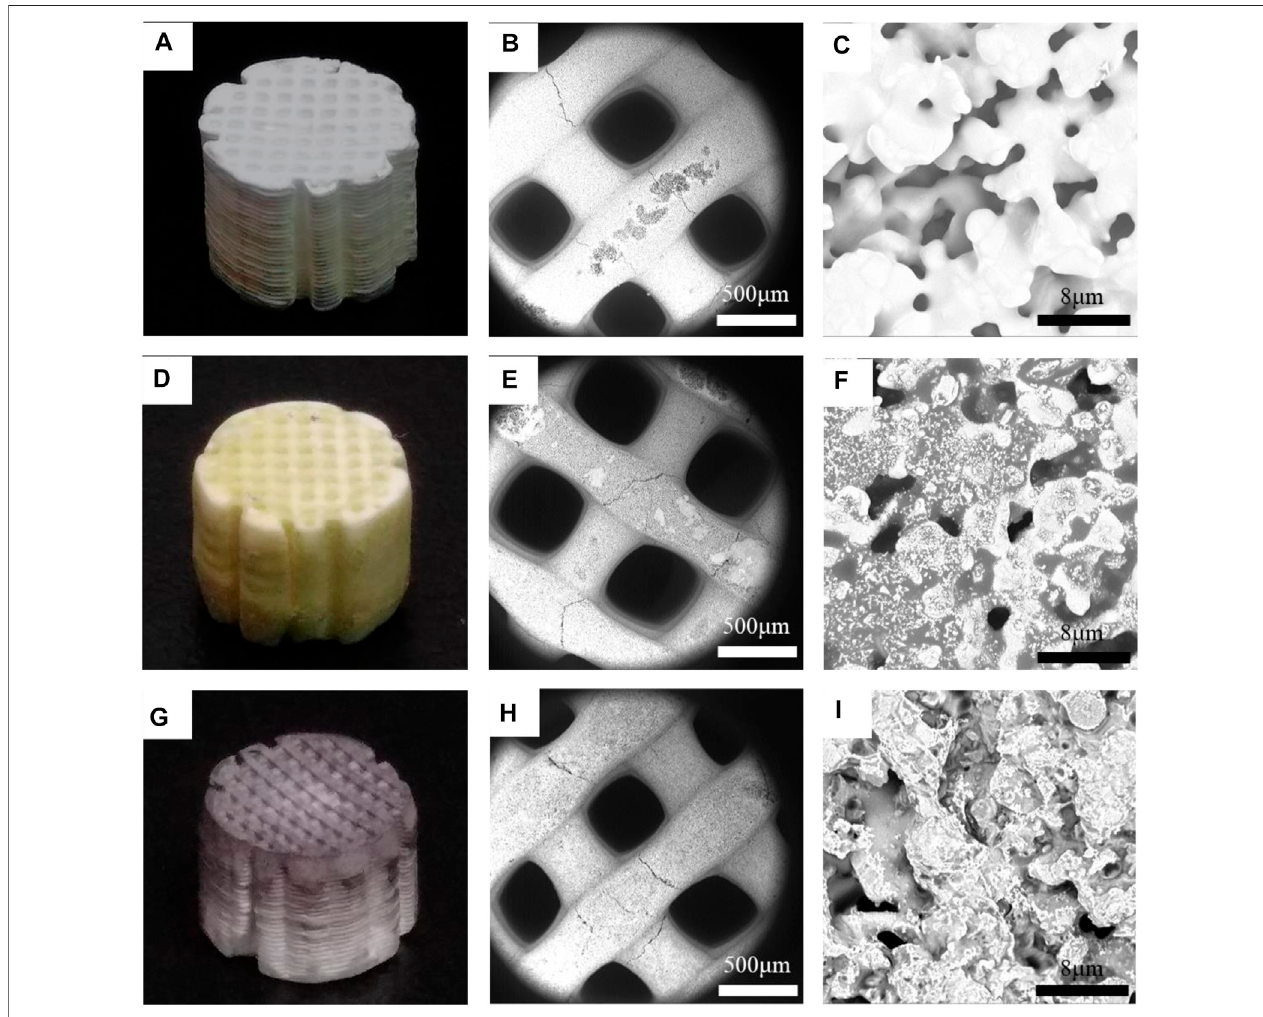
FIGURE 2 | Optical images of (A) 3D SiO 2 , (D) 3D SiO 2 -NH-SO 3 H, and (G) 3D SiO 2 -NH-SO 3 H after one catalytic cycle. SEM images of (B,C) 3D SiO 2 ; (E,F) 3D SiO 2 -NH-SO 3 H; and (H,I) 3D SiO 2 -NH-SO 3 H after one catalytic cycle at different magni fi